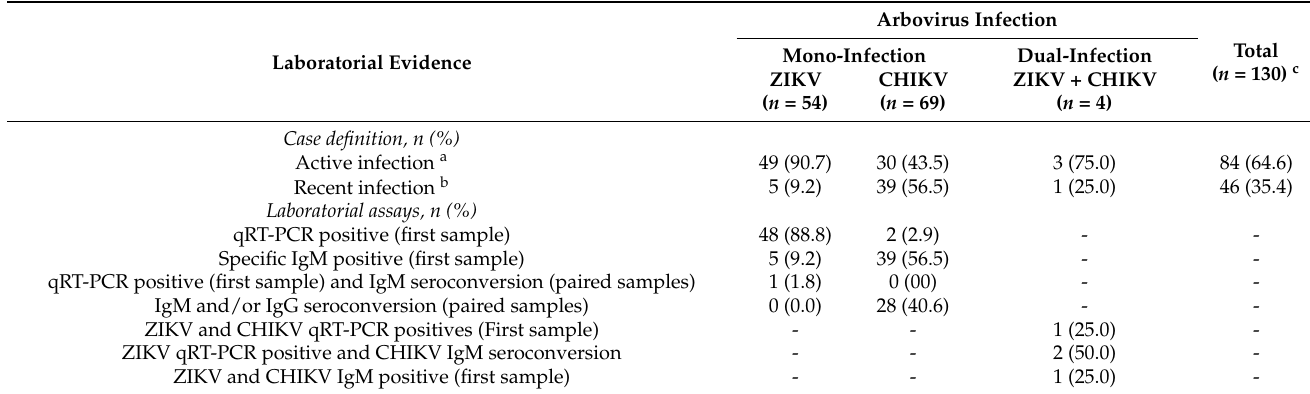
Table 2. Distribution of ZIKV and CHIKV mono and dual infection according to the case definition (active or recent) and laboratory assays.